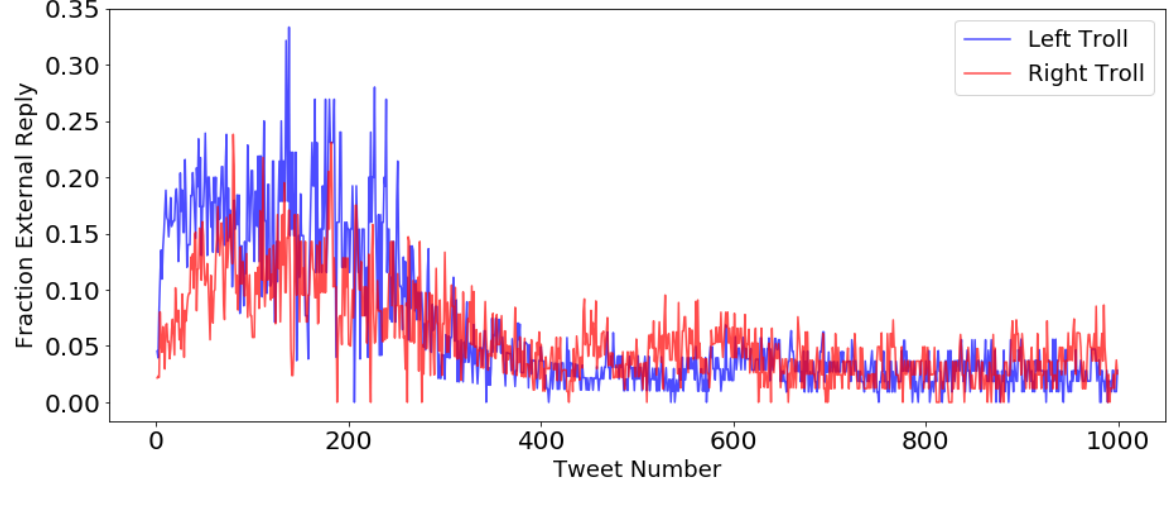
Appendix Figure 2. Fraction of Tweets that were External Replies as a Function over the Tweet Sequence of the Account, for Left and Right Trolls